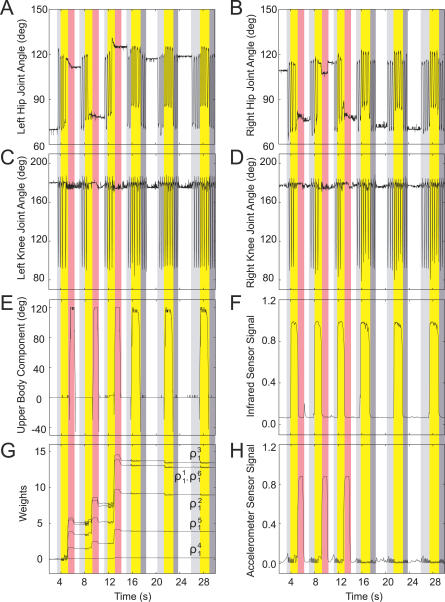
Real-Time Data of All Leg Joints and Body MotionThe data was recorded while RunBot was initially walking from a lower floor (light gray areas) to an upper floor (dark gray areas) through a ramp (yellow areas). Red areas represent situations where RunBot falls backward and white areas where RunBot was manually returned to the initial position. In this experiment, RunBot can manage to walk on an 8° ramp after three falls.(A–D) Show the left and right joint angles at all situations.(E) Shows the posture of the UBC where 0° means leaning backward while 120° mean leaning forward.(F,H) Show the predictive (IR) and reflexive (AS) signals, respectively. The growing synaptic strengths (compare Figure 13A) during the learning phase are represented in (G).